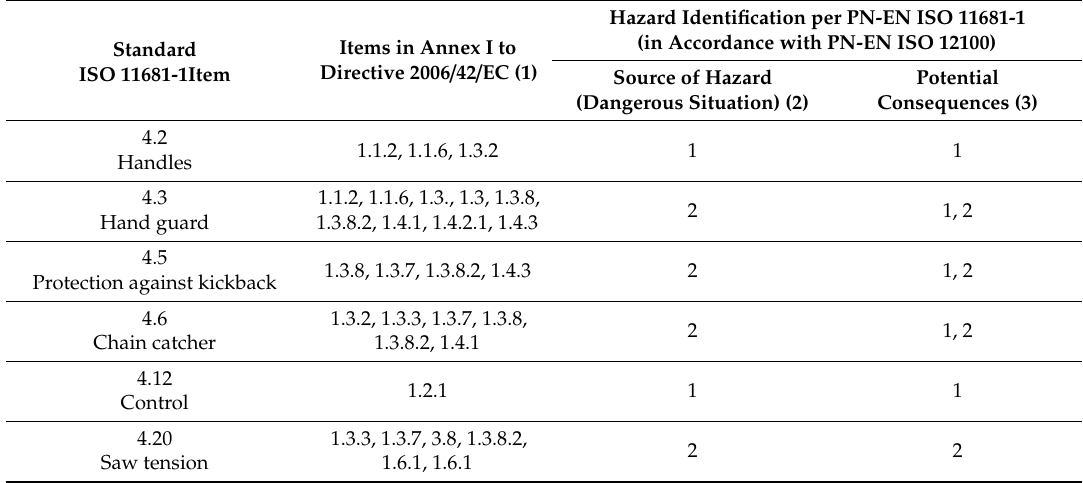
Table 2. ComparisonofdiscussedandtestedcharacteristicsofchainsawsaccordingtoDirective2006 / 42 / EC.